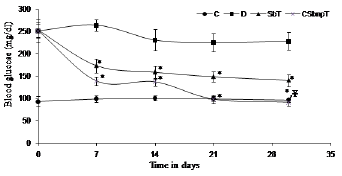
Figure 4. Blood glucose level in different groups during the 4 weeks experimental period. C – control group, D – diabetic group, SbT – Sb treated group, CSbnpT – CSbnp treated group. Results were expressed as mean 6 SD (n=6). *P , 0.001 highly significant difference compared with diabetic group. ¥ P , 0.001 highly significant difference when compared between SbT and CSbnpT.